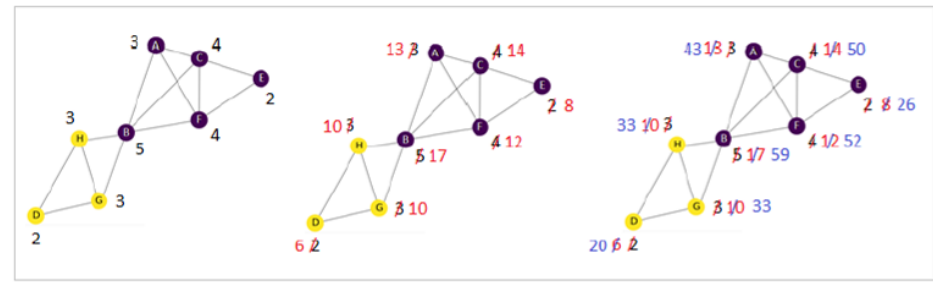
Figure 2. Iterations of the eigenvector